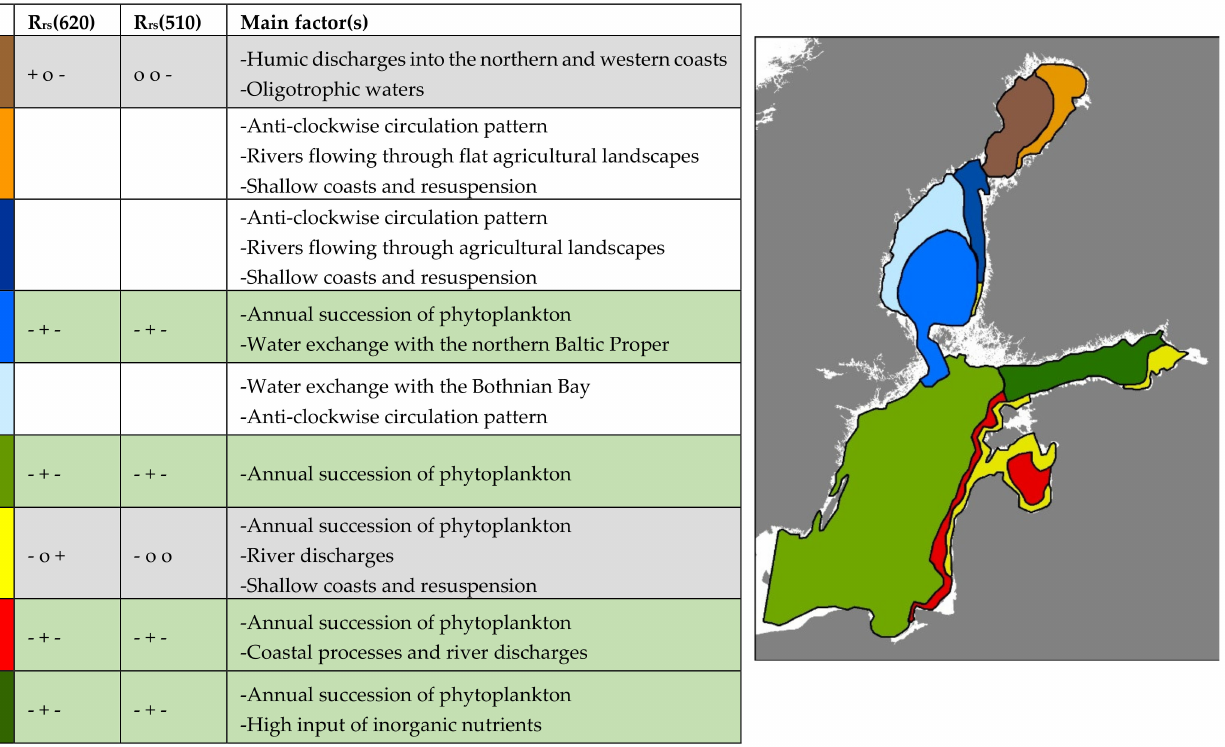
Figure 15. Schematic representation of distinctive surface layer reflectance dynamics in the Baltic Sea. The rows marked green are characterized by higher reflectance in mid-summer, whereas rows marked grey show other types of annually repeated dynamics. In the rows with no color there were no annually repeated dynamics, although their dynamics were internally more or less